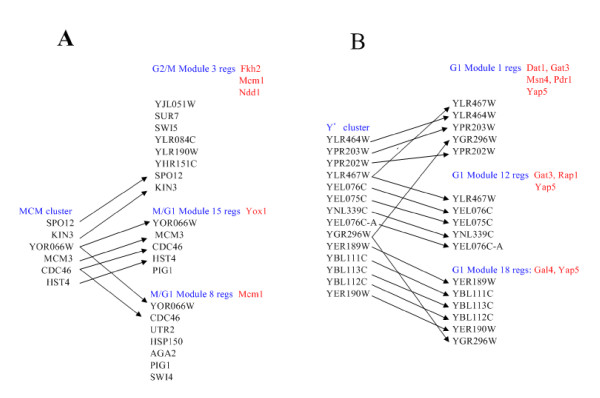
Refining clusters from Spellman et al.. (A) Refining the MCM cluster in [7]. The modules identified by MOFA differ not only in the set of TFs regulating the modules, but also in the different cell cycle phases to which they belong, providing a better understanding of how the cell regulates the complex expression program of the yeast cell cycle. Our results confirm previous findings that Mcm1 collaborates with Yox1 to regulate genes in M/G1 (e.g. YOR066W and CDC46) [30] and collaborates with Ndd1 and Fkh1/Fkh2 to regulate genes in G2/M (e.g. SPO12 and KIN3) [36]. (B) Refining the Y' cluster in [7]. The Y' cluster contains genes that share DNA sequence similarity and are found in Y' elements, which are located at chromosome ends. Spellman et al. [7] did not figure out how these genes are regulated. MOFA reassigns genes in the Y' cluster to three modules and identifies several possible regulators (Dat1, Gal4, Gat3, Hap1, Hap4, Msn4, Pdr1, Rap1 and Yap5), providing information for future experiments.